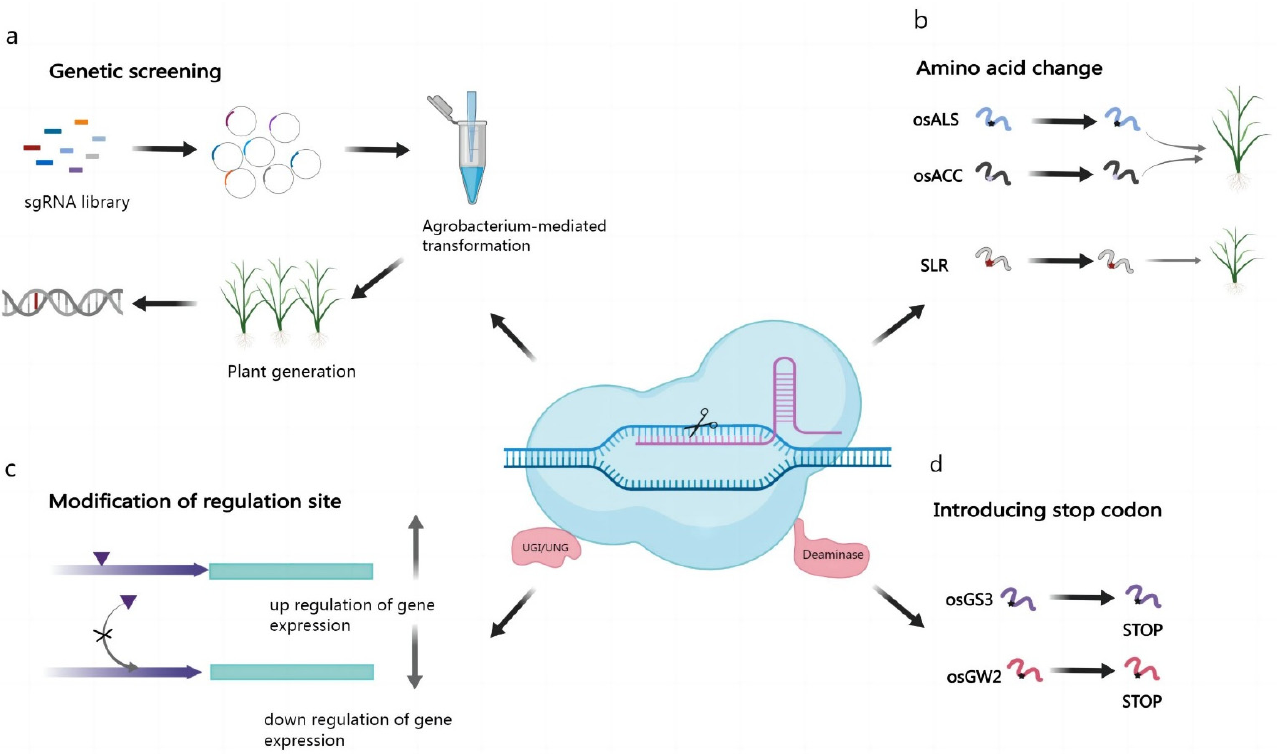
Figure 2. Applications of base editing technology in crops. ( a ) Construction of sgRNA libraries for gene screening; ( b ) Single base mutations causing amino acid changes and thus developing superior traits; ( c ) Editing regulatory factors to regulate gene expression; ( d ) Introduction of stop codons in advance to regulate gene expression.